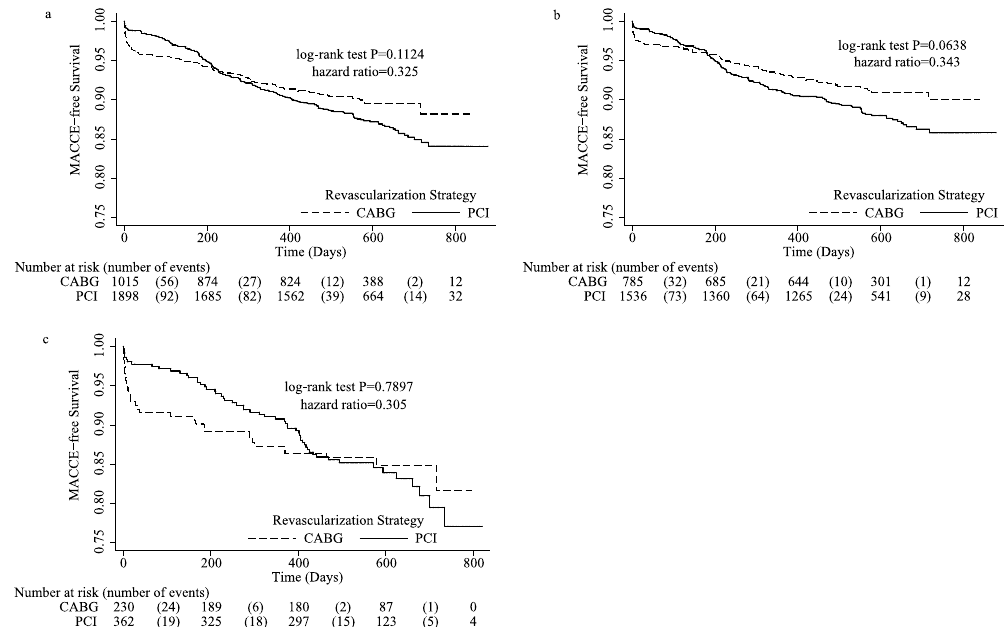
Figure 1. MACCE-free Kaplan-Meier survival curve. ( a ) MACCE-free Kaplan-Meier survival curve for ACS patients with renal dysfunction undergoing CABG versus PCI. ( b ) MACCE-free Kaplan-Meier survival curve for the mild renal dysfunction subgroup undergoing CABG versus PCI. ( c ) MACCE-free Kaplan-Meier survival curve for the moderate or severe renal dysfunction subgroup undergoing CABG versus PCI. Hazard ratios represent the adjusted hazard ratios of PCI relative to CABG at the initial time after revascularization. ACS, Acute coronary syndrome; CABG, Coronary Artery Bypass Graft; MACCE, major adverse cardiac and cerebrovascular events; PCI, Percutaneous Coronary Intervention.